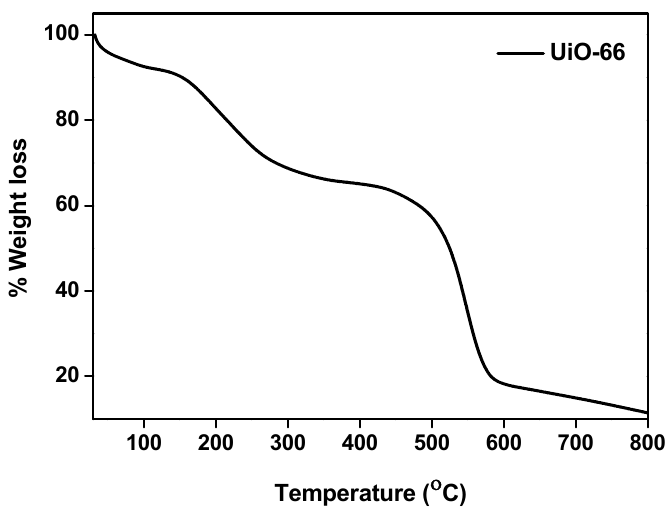
Figure 5. TGA graphs of UiO ‐ 66.